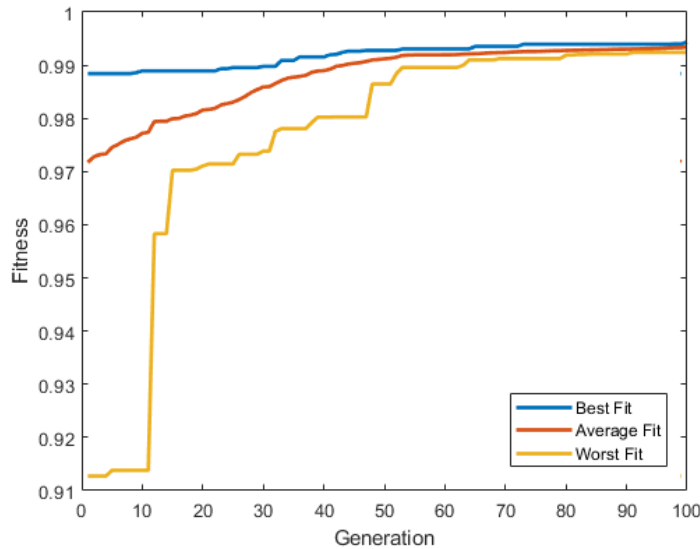
Figure 8. Evolution of the best, worst, and average fitness for DE 2.